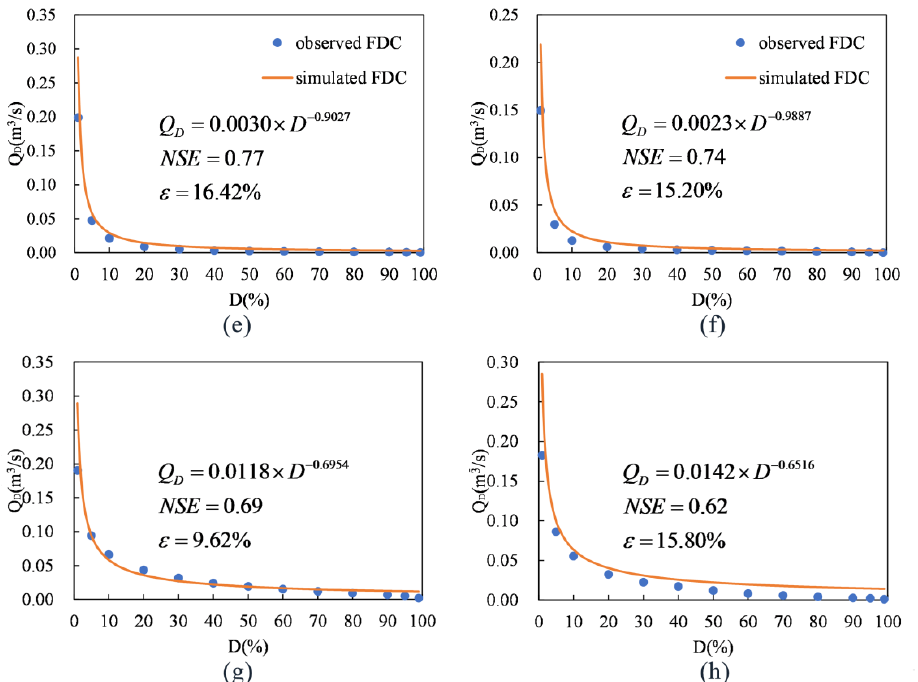
Figure 6. The simulated and observed FDCs of eight basins from different NSE gradient ranges: ( a ) Dapoling (ID. 8), ( b ) Zhangchong (ID. 17), ( c ) Hengtangcun (ID. 45), ( d ) Lixin (ID. 6), ( e ) Zhongtang (ID. 2), ( f ) Xiagushan (ID. 4), ( g ) Laoshikan (ID. 41) and ( h ) Hongtian (ID. 61).